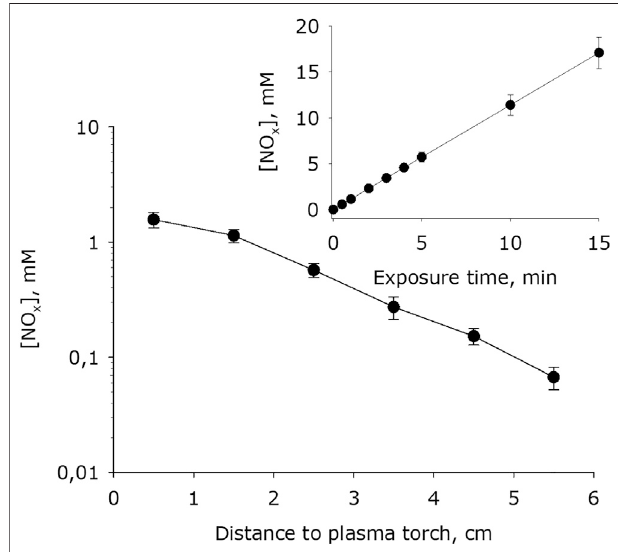
FIGURE 10 | Dependence of nitrite and nitrate anions concentration formed in water on distance from water surface to the plasma jet nozzle at 1 min of plasma exposure. Data are presented as mean standard error for three independent experiments. Inset shows dependence of nitrite and nitrate anions concentration formed in water on the time of plasma exposure at 1.5 cm distance from water surface to the plasma jet nozzle. The data are presented as average values with standard deviation of three experiment